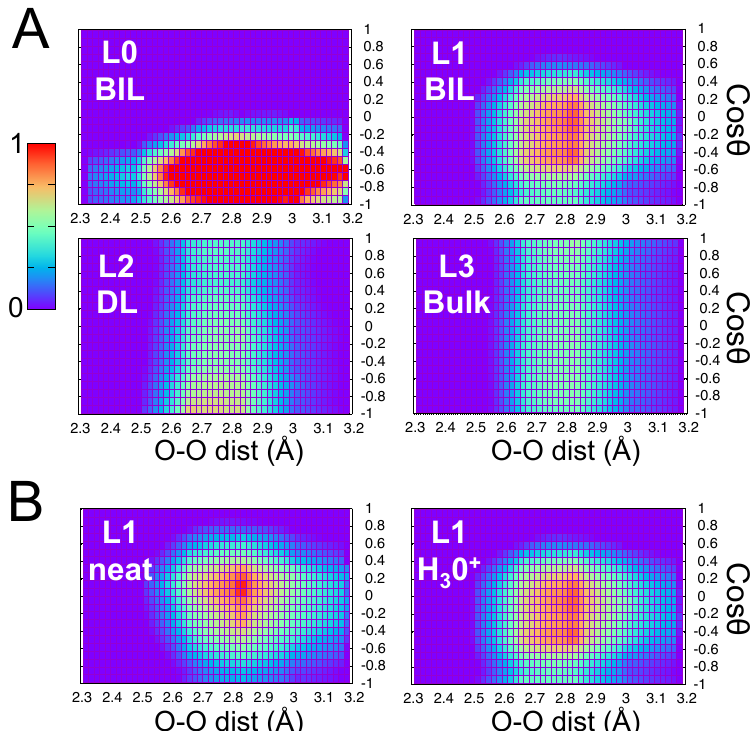
Figure 4. ( A ) 3D-plots of the H-bond patterns formed between the water molecules in each (L0–L3) layer, calculated as an average over the four independent simulations performed in this work. The x-axis represents the O-O distance (Å) between 2 H-Bonded water molecules and the y-axis provides the angle (cosine value) between the O-O vector (from donor to acceptor) and the normal to the surface (oriented from liquid to vapour phase). The colors represent the probability (P) to find one O-H group forming one HB with a given distance and orientation. The probability increases from blue to red. For each layer, the final assignment to BIL/DL/Bulk is also reported in the figure. ( B ) Comparison between the L1 layer 3D-plots obtained for the acidic (same as in panel A) and neat (from Ref. [26]) AW